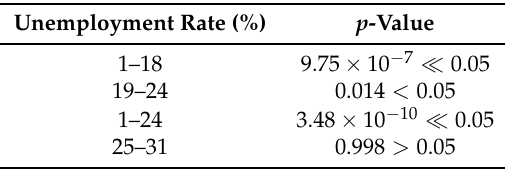
Table 4. Results of t -test in specific unemployment rate ranges. Results are significant for unemployment rate in the range 1%–24%.